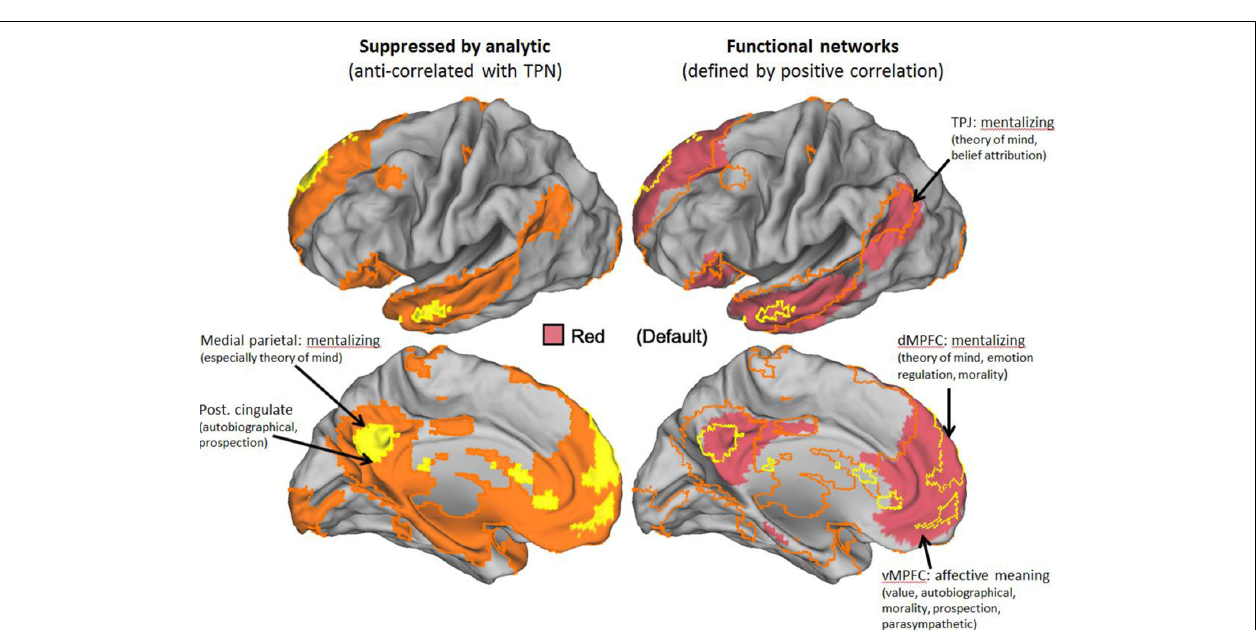
global regressor (i.e., most strongly anticorrelated areas). Maps derived from data and methods described in Jack etal. (2012). Right panels show the seven network stable solution derived by Yeo etal. (2011) on the basis of positive correlations in resting state data. Area shown in black corresponds to a cross-section through sub-cortical structures, not mapped by Yeo etal. (2011).